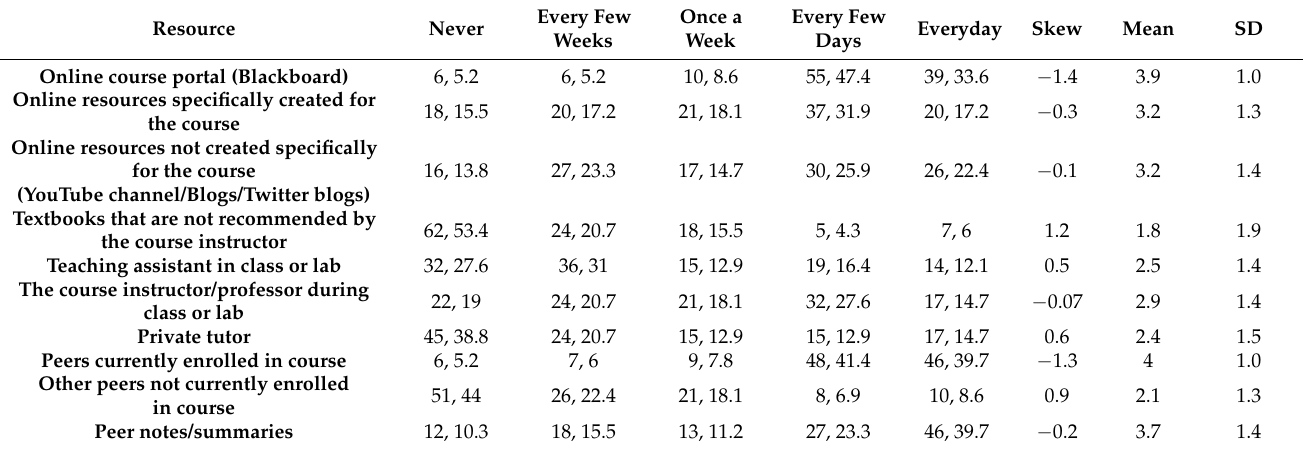
Table 3. Frequency of use of academic